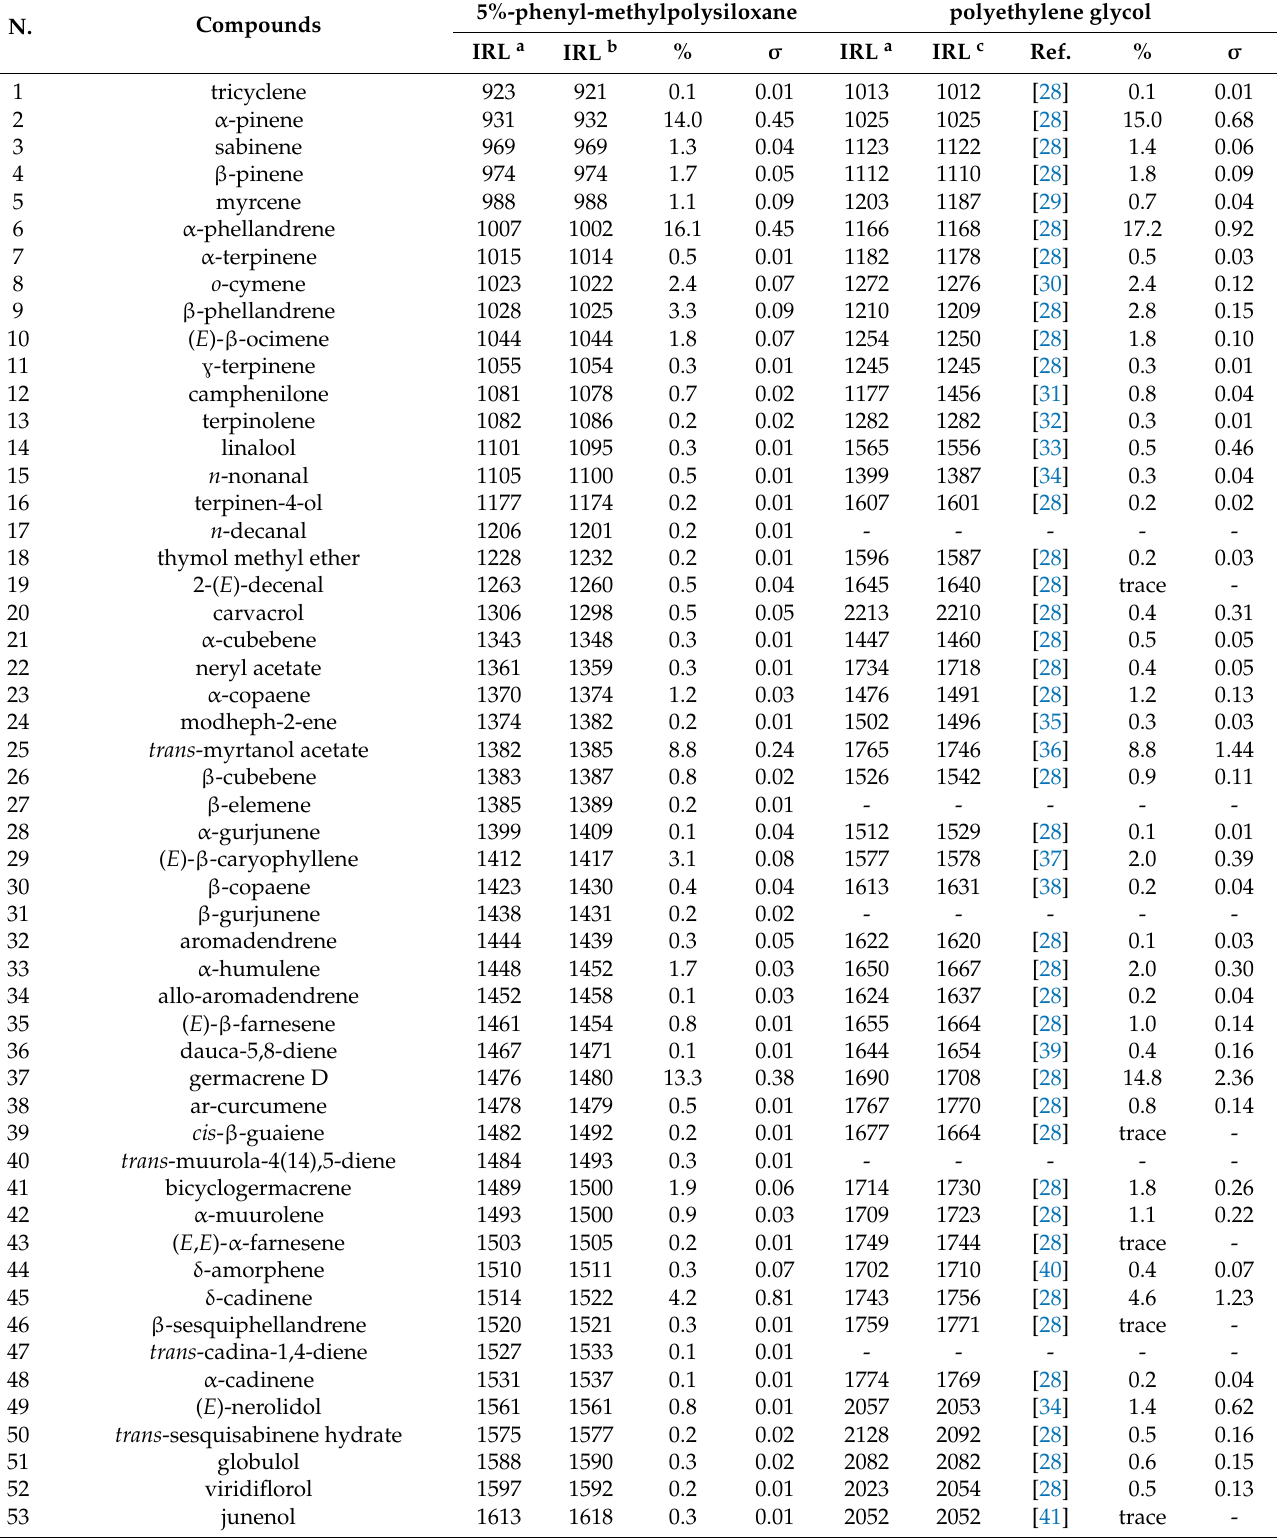
Chemical analyses of G. miniphylla EO obtained with non-polar (5%-phenyl- methylpolysiloxane) and polar (polyethylene glycol) capillary